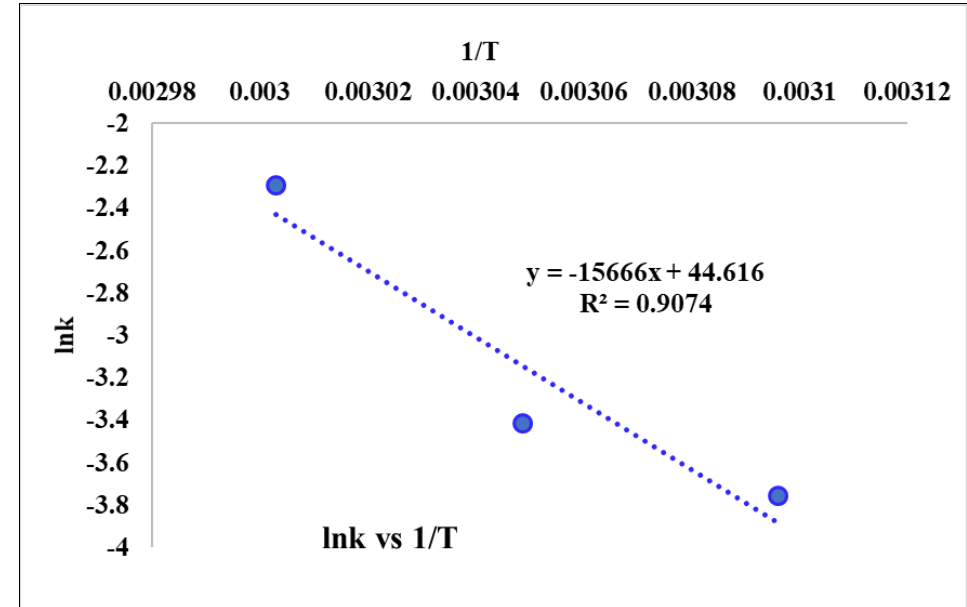
Figure 9. Determination of the activation energy of the esterification reaction process.